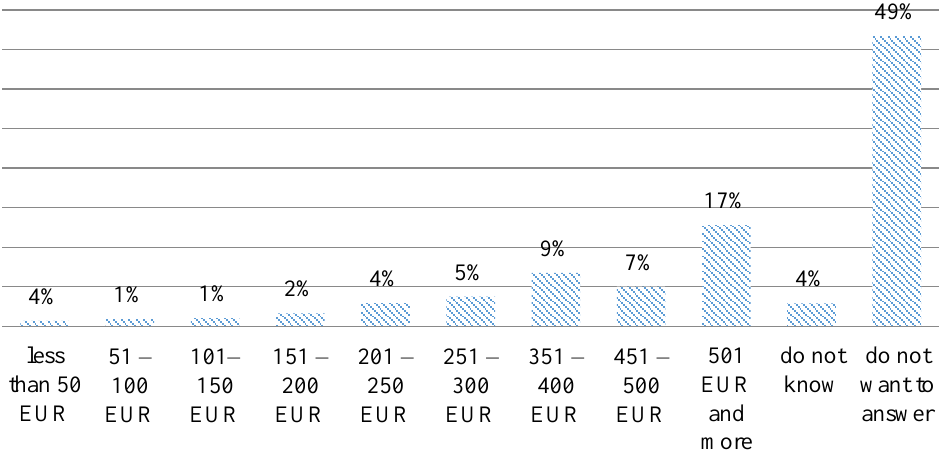
Fig. 4. Household income per family member per month,